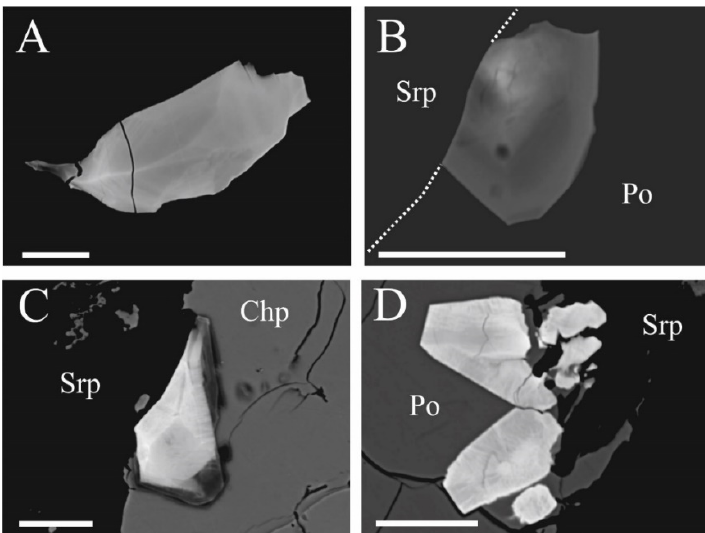
Figure 4. Back-scattered electron (BSE) images of zoned laurite. ( A ) See reflected-light image of Figure 3B for the mineralogical assemblage of the grain. ( B ) Laurite in contact with pyrrhotite and serpentine, ( C ) laurite in contact with chalcopyrite and serpentine and ( D ) laurite grains in contact with pyrrhotite and serpentine Abbreviations as in Figure 3. Scale bar = 20 µm. Table 2. WDS electron microprobe analyses of Merensky Reef zoned laurite. Sample